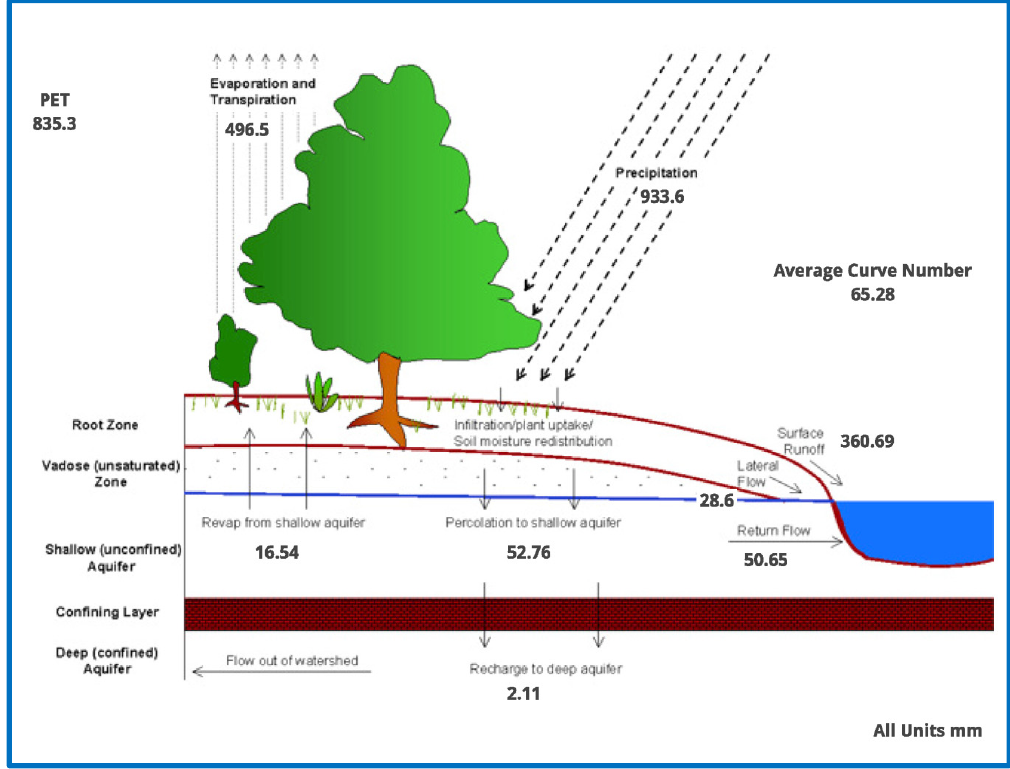
Figure 7. Hydrological outputs (process-based diagram) generated by SWAT-Check (diagrams for sediment and nutrient processes are also available in SWAT-Check